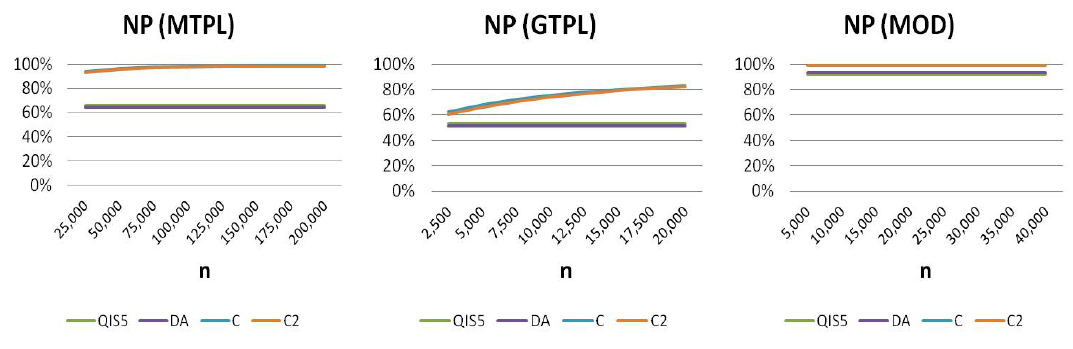
Figure 5. NP LoB according to several values of expected claims count ( n